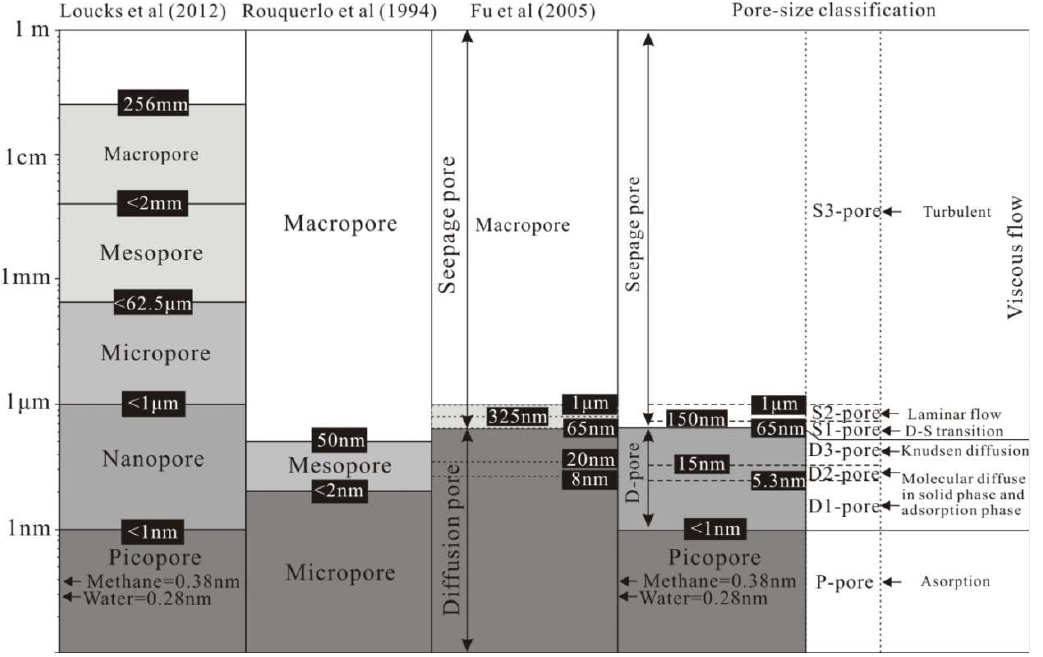
Figure 7. Pore size classification based on the fractal characteristics and kinetic characteristics of methane molecules. A comparison was made with the Rouquerol et al. (1994) [65] pore size classification, the Loucks et al. (2012) [64] mudrock pore size classification, and the Fu et al. (2005) [34] fractal classification.